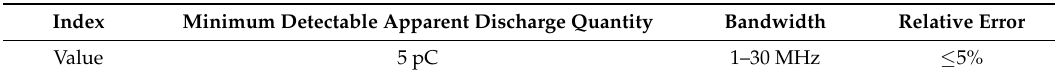
Table 2. Technical parameters of the wireless TEV